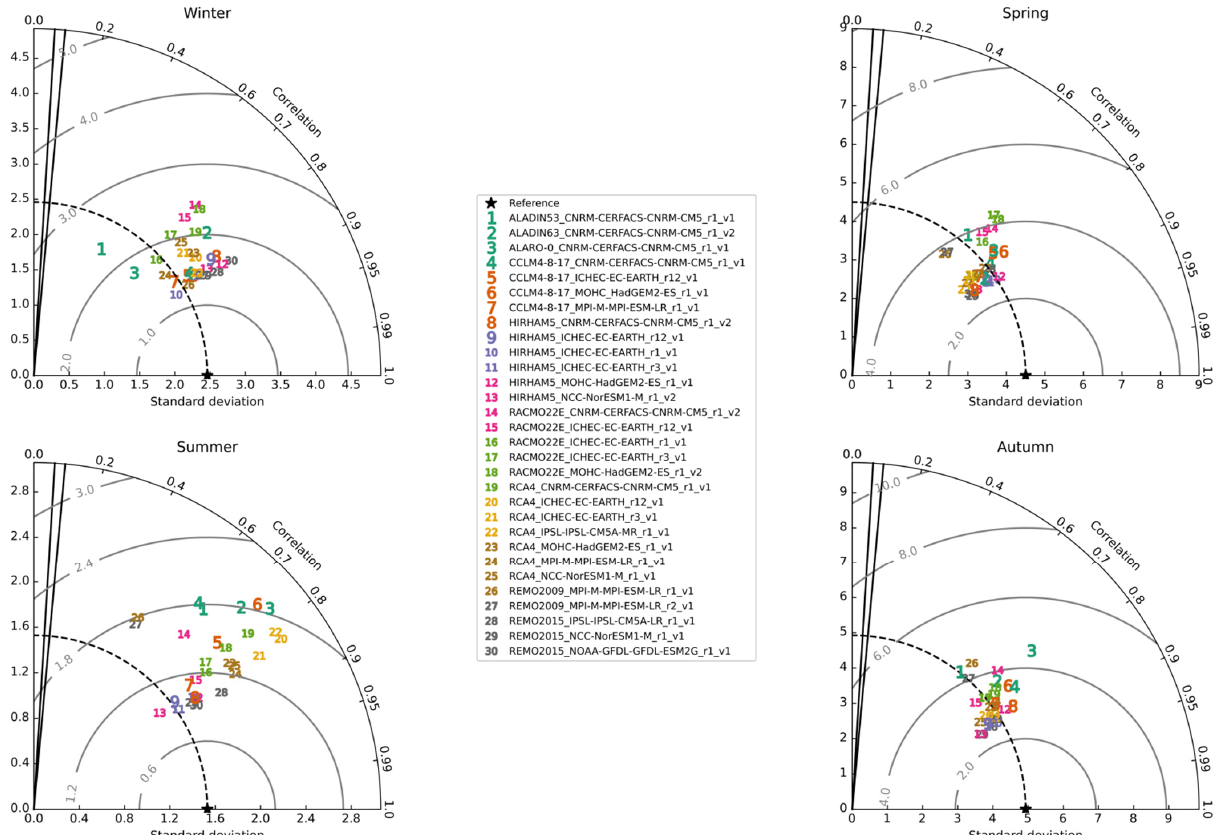
Figure 8. Taylor diagrams of seasonal (1971–2000) mean near-surface air temperature showing standard deviation (°C), centered RMSE (°C), and spatial correlation for each EURO-CORDEX GCM–RCM simulation versus E-OBS observations across the Pannonian Basin. The four panels refer to the four seasons defined as winter (DJF), spring (MAM), summer (JJA), and autumn (SON). The observed field is labeled with a star symbol. The dotted line depicts the contour of the reference standard deviation (the observed field). The RMSE contours are grayed out. The 95th and 99th significance levels are represented by the correlation rays on the left and right, respectively.